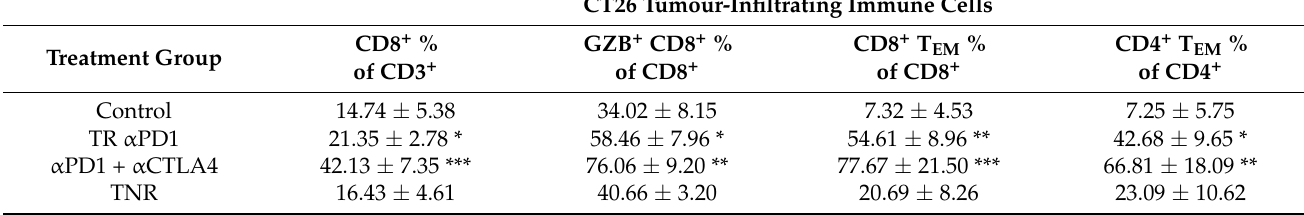
Table 2. Flow cytometry showing immune cell types associated with positive response to α PD1 or combined α PD1 + α CTLA4 therapy in CT26 tumour bearing mice. Percentages of T cell subpop- ulations across control groups, treatment responder (TR) arms, and all treatment non-responsive tumours (TNR) across all treatment arms. Data are shown as the mean % of cells ± S.D. and are representative of n = 5–10 mice/ group, * p < 0.05; ** p < 0.01, *** p < 0.001 comparing TR to TNR. CT26 Tumour-Infiltrating Immune